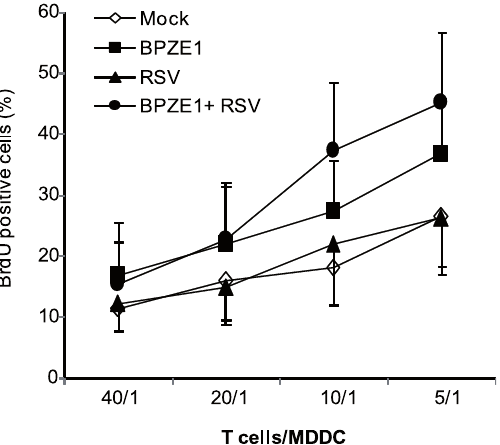
Figure 3. Impact of BPZE1 on RSV-induced allogeneic T cell proliferation. MDDC were infected with RSV (MOI of 1), BPZE1 (bacteria/cell ratio of 100:1), or both. Mock-infected cells were added as control. After 48 h, MDDC were co-cultured with allogeneic purified T cells at increasing T cells/MDDC ratios (5/1, 10/1, 20/1, 40/1) for 6 d. Results are reported as percentages of BrdU positive cells (mean 6 SEM of 4 independent experiments performed with MDDC obtained from different